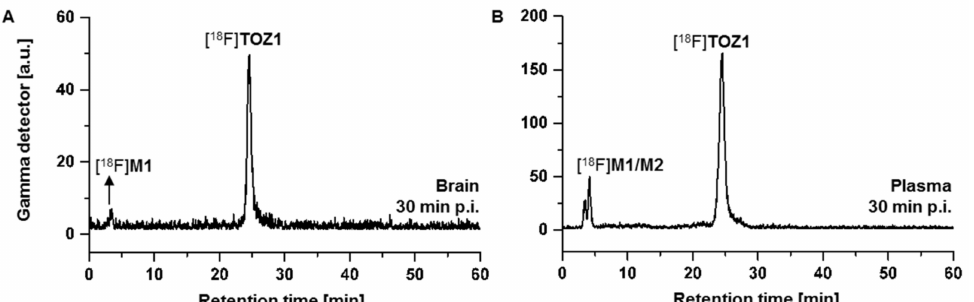
Figure 6. Representative radio-chromatograms of the in vivo metabolism study of extracted mouse ( A ) brain and ( B ) plasma samples at 30 min post injection (p.i.) of [ 18 F] TOZ1 (ReproSil-Pur 120 C18- AQ column (250 × 4.6 mm, 5 µ m), 10-90-10% MeCN/20 mM NH 4 OAc aq ., flow rate: 1